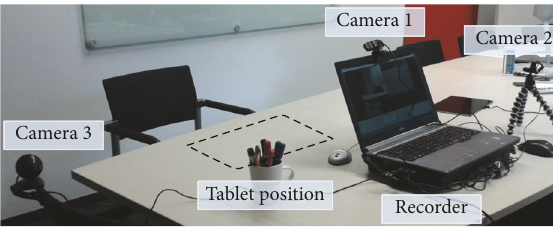
Figure 8: User testing setup for the usability evaluation of the prototypes. In this environment, a user performs an interactive segmentation on a mobile tablet computer while sitting. RGB cameras record the hand motions on the input device and facial expressions of the participant. In addition, each recognized input is recorded on the tablet device (the interaction log).